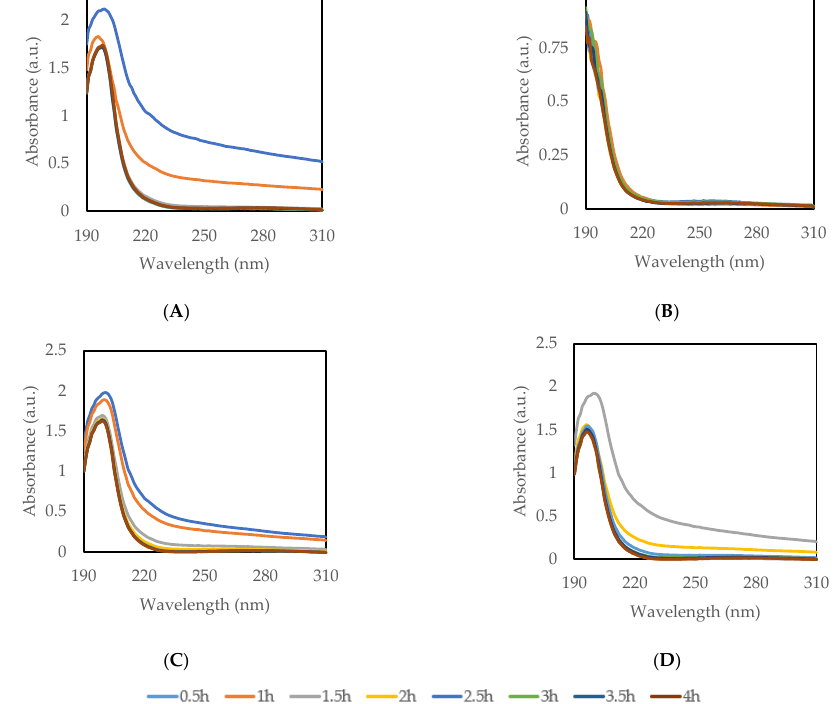
Figure A7. The UV-Vis spectra of samples after 24 h incubation at 20 ◦ C. ( A ) chitin powder, ( B ); chitosan powder, ( C ) chitin nanocrystals (ChNC), ( D ) deacetylated chitin nanocrystals